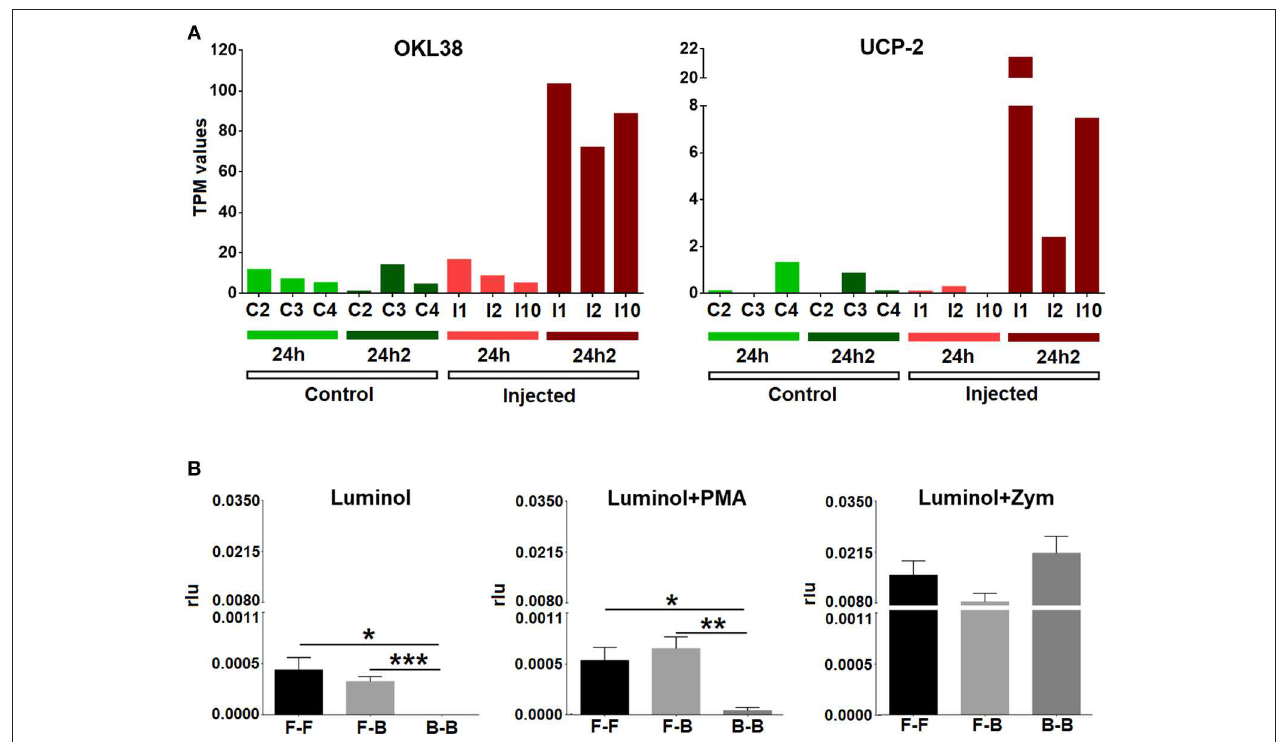
FIGURE 6 | (A) Expression values (TPM) for two representative inhibitors of oxidative stress (OKL38 and UCP-2) in the six studied individuals (C2, C3, C4, I1, I2, and I10) at two experimental time points (24 hpi and 24 hpi2). (B) Respiratory burst assay. Bars represent the mean percentage and standard error of the relative luminescence units (rlu) for the total hemocytes in eight individual mussels. Asterisks show the statistical significance: * p < 0.05; ** p < 0.001; and *** p < 0.0001. Subsequent stimulations are indicated as follows: F-F, FSW and FSW; F-B, FSW and bacteria; B-B, bacteria and